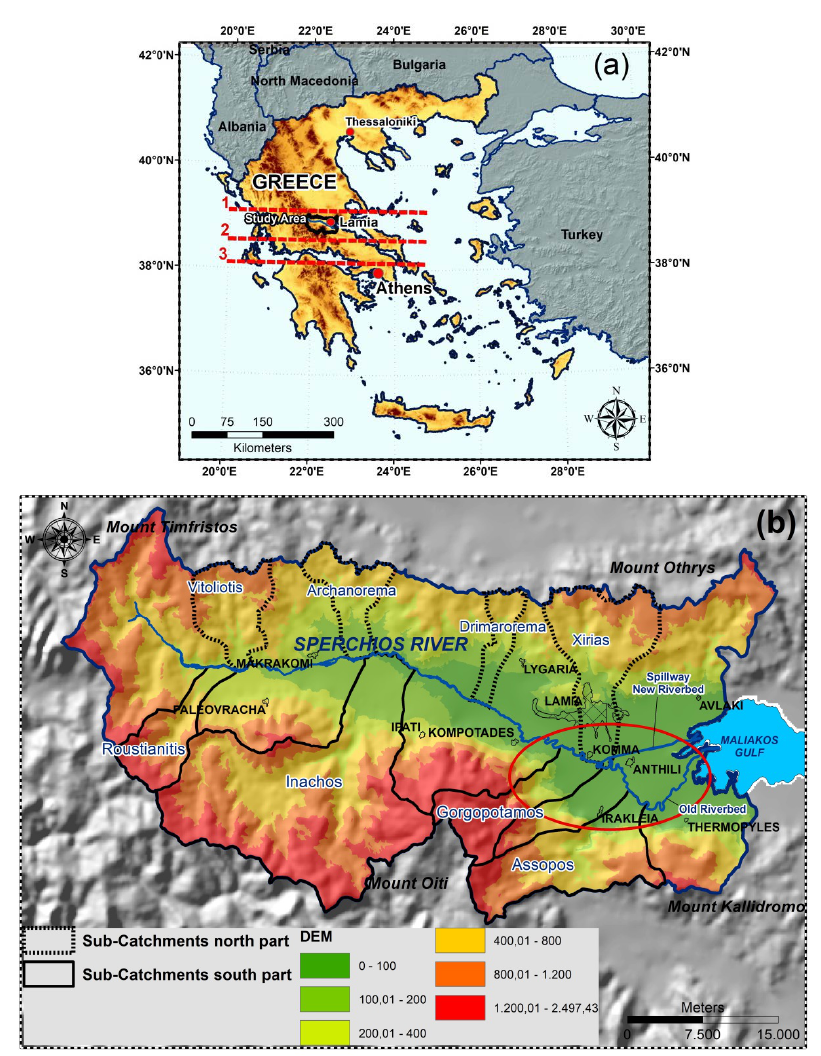
Figure 1. ( a ) The location of Sperchios river catchment in Central Greece (red lines and numbers 1, 2 and 3 showing the three areas of tectonic dipole’s theory), ( b ) The morphology of the catchment and the distribution of the four main sub-catchments of its south part (Roustianitis, Inachos, Gorgopotamos and Assopos) and the corresponding sub-catchments of the north part (Vitoliotis, Archanorema, Drimarorema and Xirias). The red ellipse line shows the intense meandering part of River Sperchios.